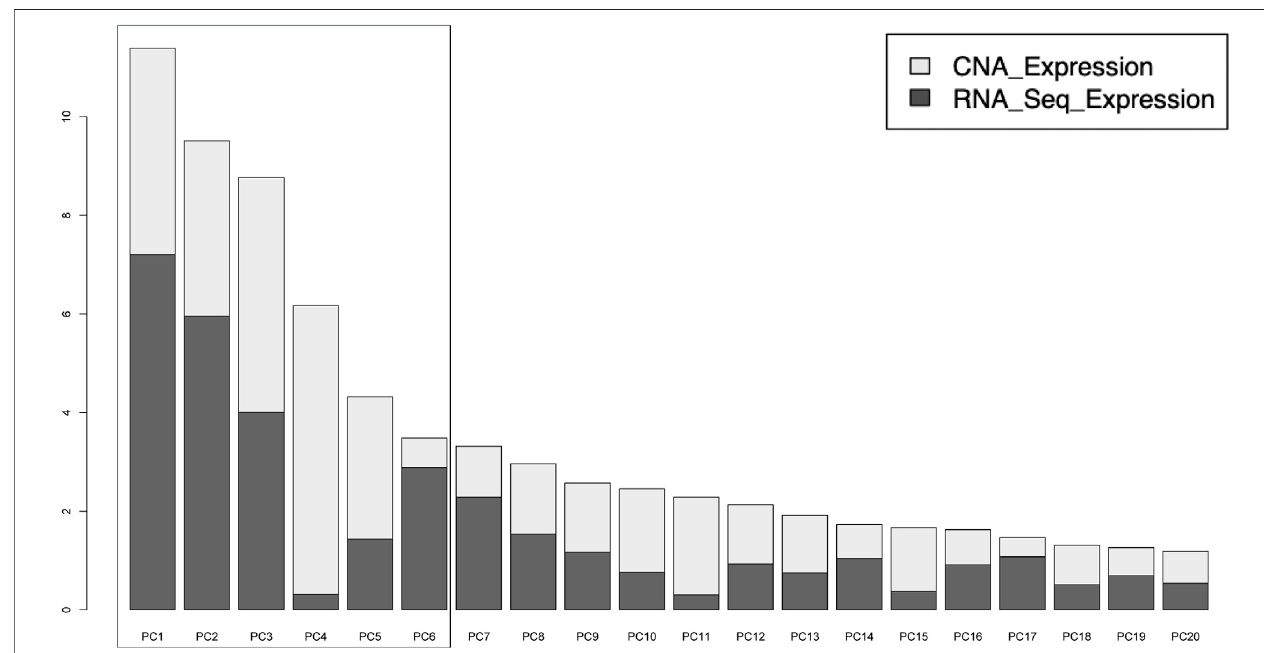
FIGURE 1 | Distribution of variances explained by the 20 principal components (PCs). The fi rst six PCs were used to identify subgroups by clustering. These contained a total of 43.6% of total variance, with CNA and Gene expression contributing equally.